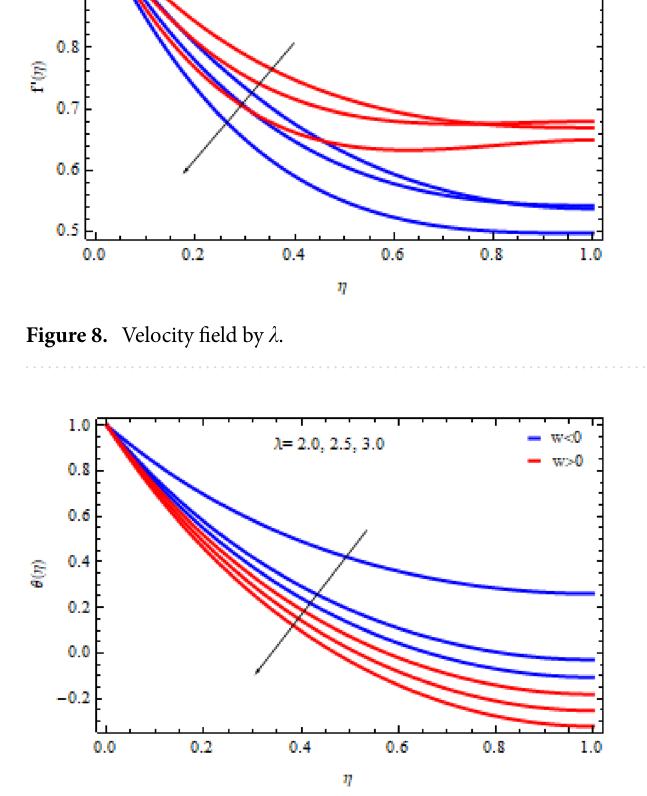
Figure 9. Temperature field by (cid:31) .